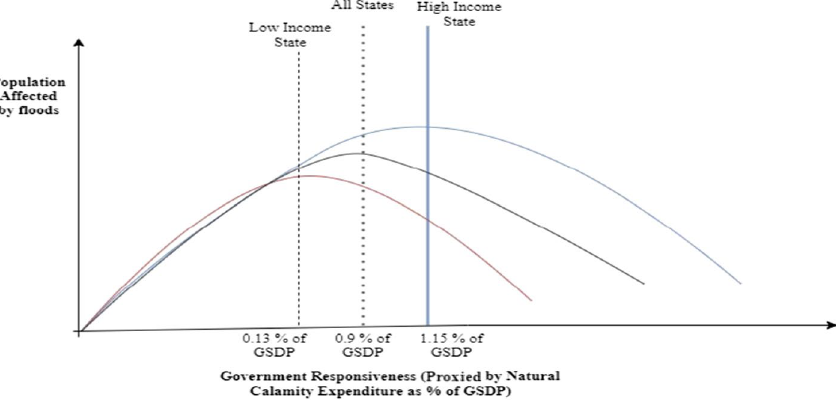
Figure 6. Turning point for population affected by floods with Government responsiveness—all states, high income, and low-income